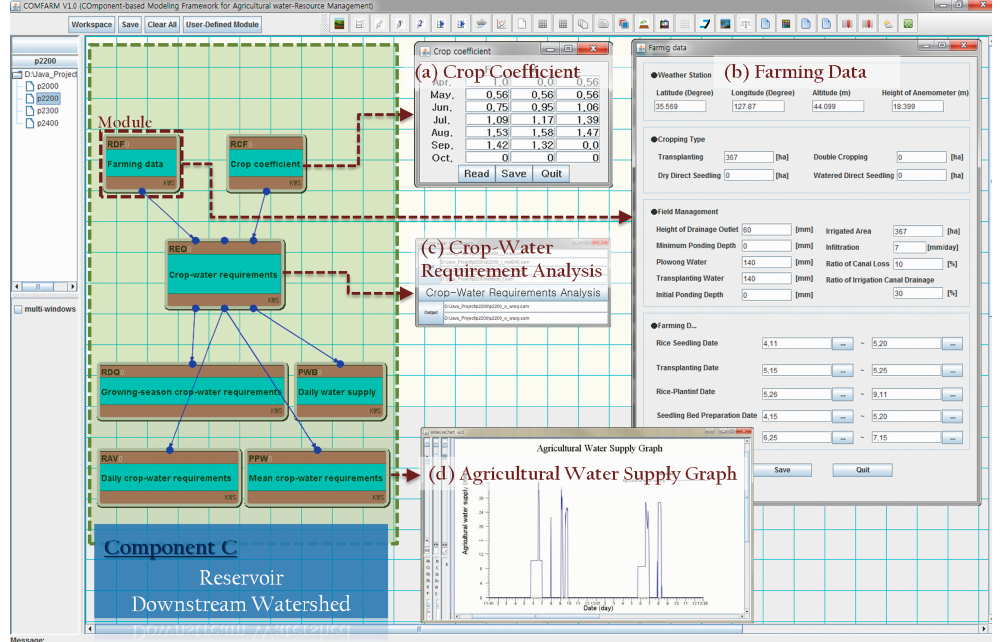
Figure 8. Downstream ‐ watershed reservoir. Dialog boxes: ( a ) sets crop coefficients; ( b ) determines the parameters for the analysis of evapotranspiration; ( c ) analyzes crop ‐ water requirements; and ( d ) displays the average crop ‐ water requirements.